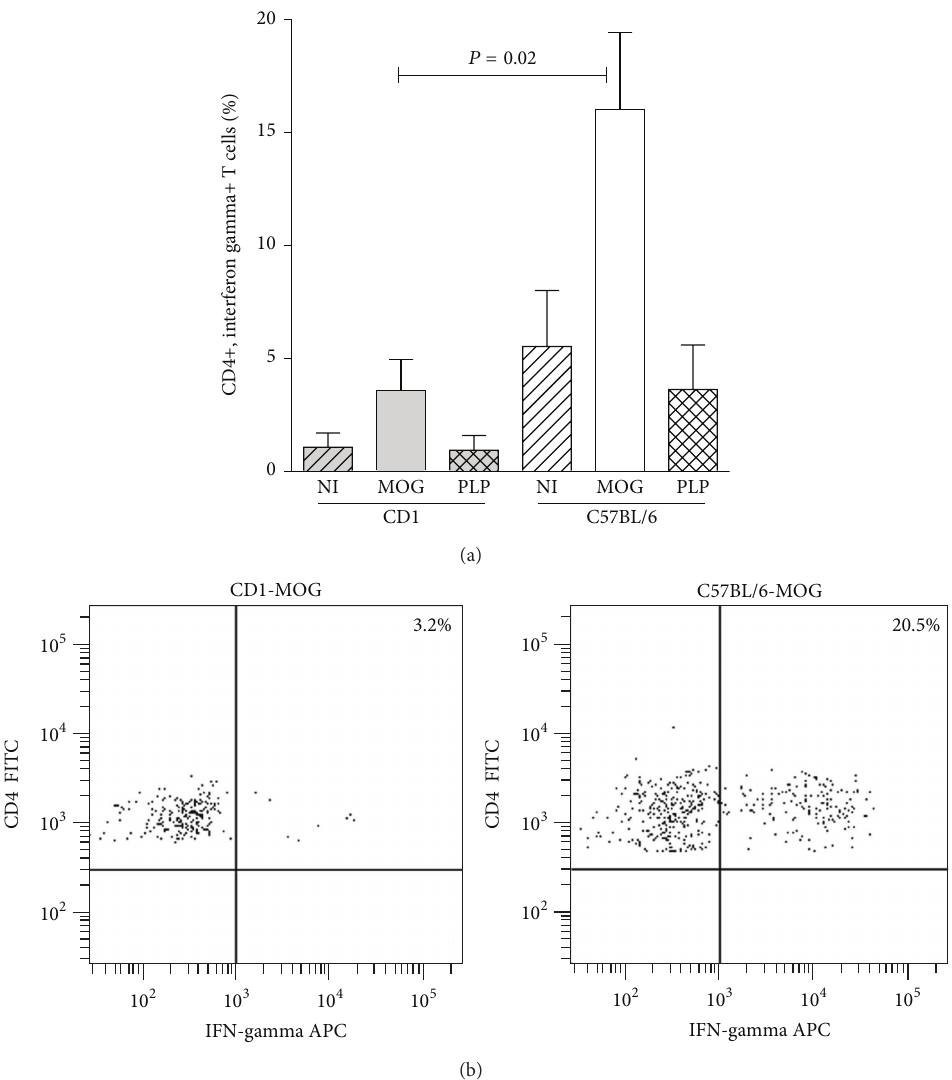
Figure 4: Intracellular production of interferon-gamma (IFN-gamma) by spleen CD4+ T cells. We analyzed these cells in series of seven mice per condition. (a) Splenocytes from C57BL/6 and CD1 mice were cultured in presence of phorbol-12-myristate-13-acetate (PMA) and ionomycin during four hours, and the percentage of CD4+ T cells showing intracellular production of IFN-gamma was analyzed by flow cytometry. We studied nonimmunized mice (NI) and mice immunized with MOG 35−55 (MOG) and with PLP 139−151 (PLP). C57BL/6 mice that developed EAE after immunization with MOG 35−55 experienced a significant increase in the percentage of CD4+ T cells producing IFN-gamma. (b) Representative dot plots of IFN-gamma intracellular staining on CD4+ T splenocytes from CD1 and C57BL/6 mice upon immunization with MOG 35−55